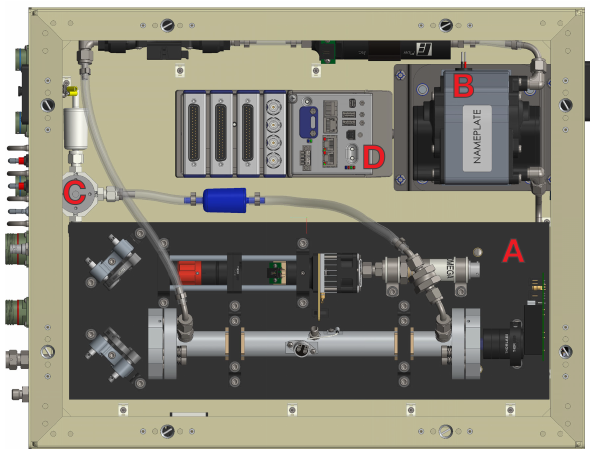
Figure 3. A top view of the ROZE instrument chassis. Major com- ponents include (a) the optical plate, which consists of the LED assembly, associated optics, the optical cell, and the PMT detector; (b) the diaphragm pump which can pull up to ∼ 18 SLM (standard liter per minute) through the flow system; (c) the three-way valve which switches between the sample line and air scrubbed of O 3 us- ing a Carulite filter; and (d) the data acquisition